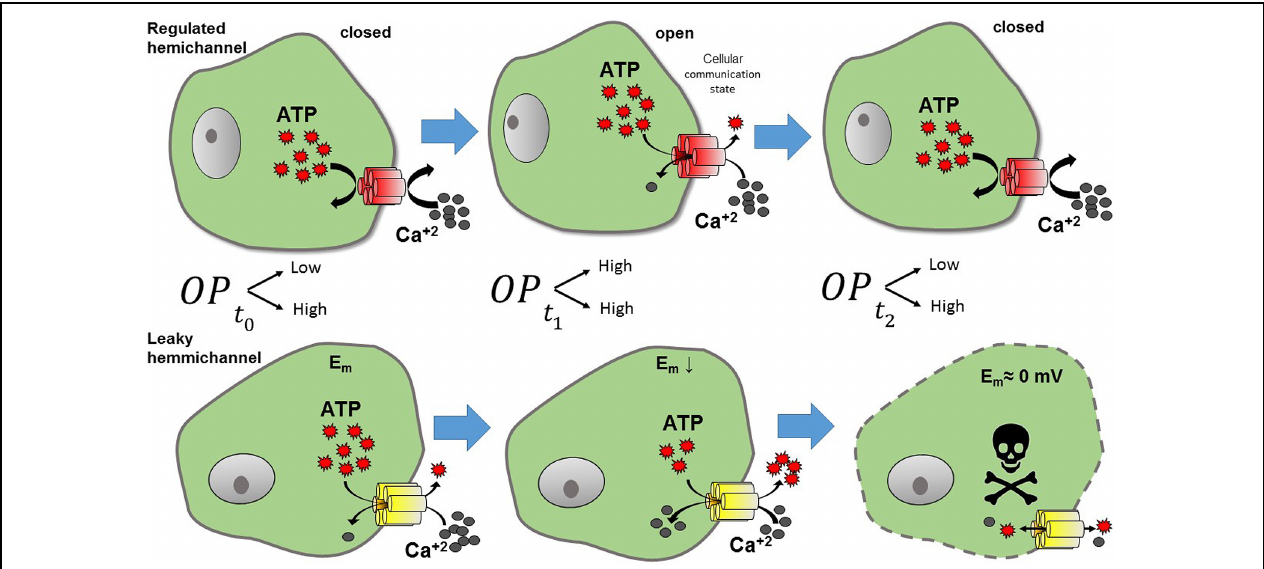
FIGURE 3 | Representation of the effects of leaky HC. Under normal conditions (upper panel) HCs present a low open probability (OP). Thus, when HCs are normally closed ( t 0 , low OP), no exchange with the extracellular milieu is observed. However, when HCs open ( t 1 , higher OP), molecules such as ATP and Ca 2 + can flow through them. Calcium may activate intracellular pathways,